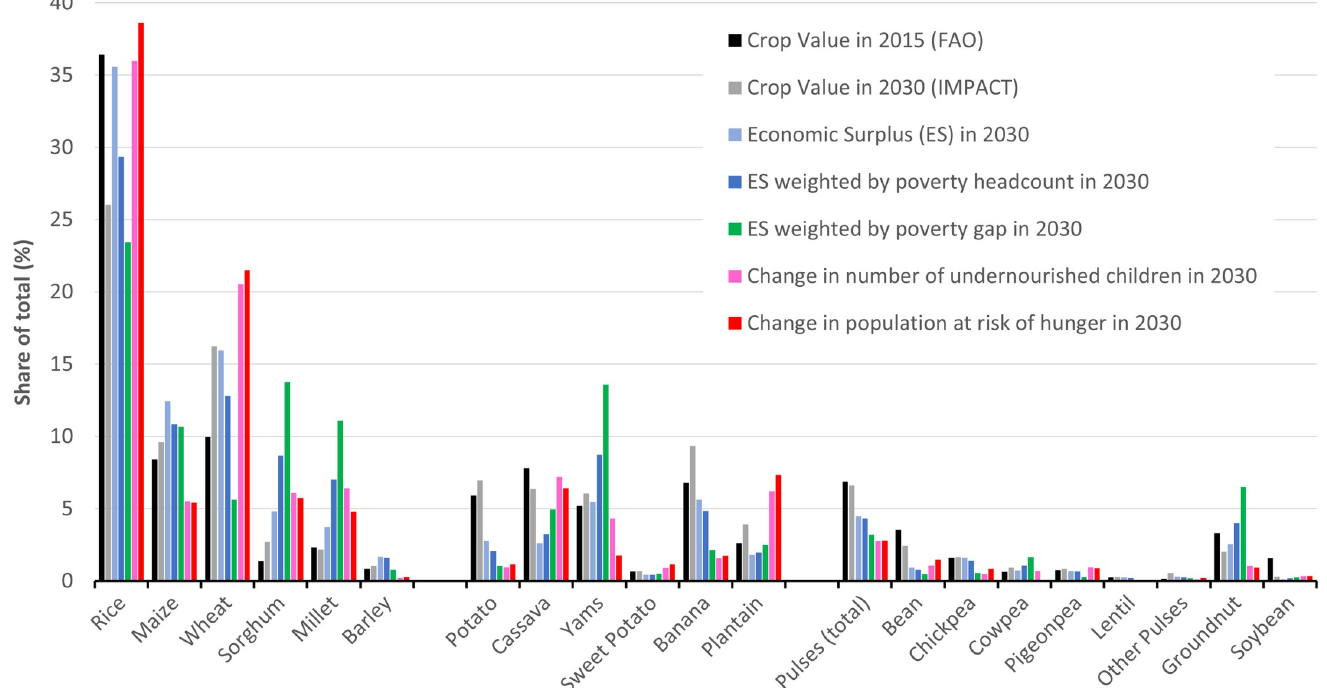
Fig 5. Relative impacts of faster productivity growth on income, poverty and food security indicators (all 106 countries). Source: The authors, based on FAOSTAT (2015 production value), IFPRI (IMPACT projections to 2030), PovcalNet (poverty measures, latest available year).